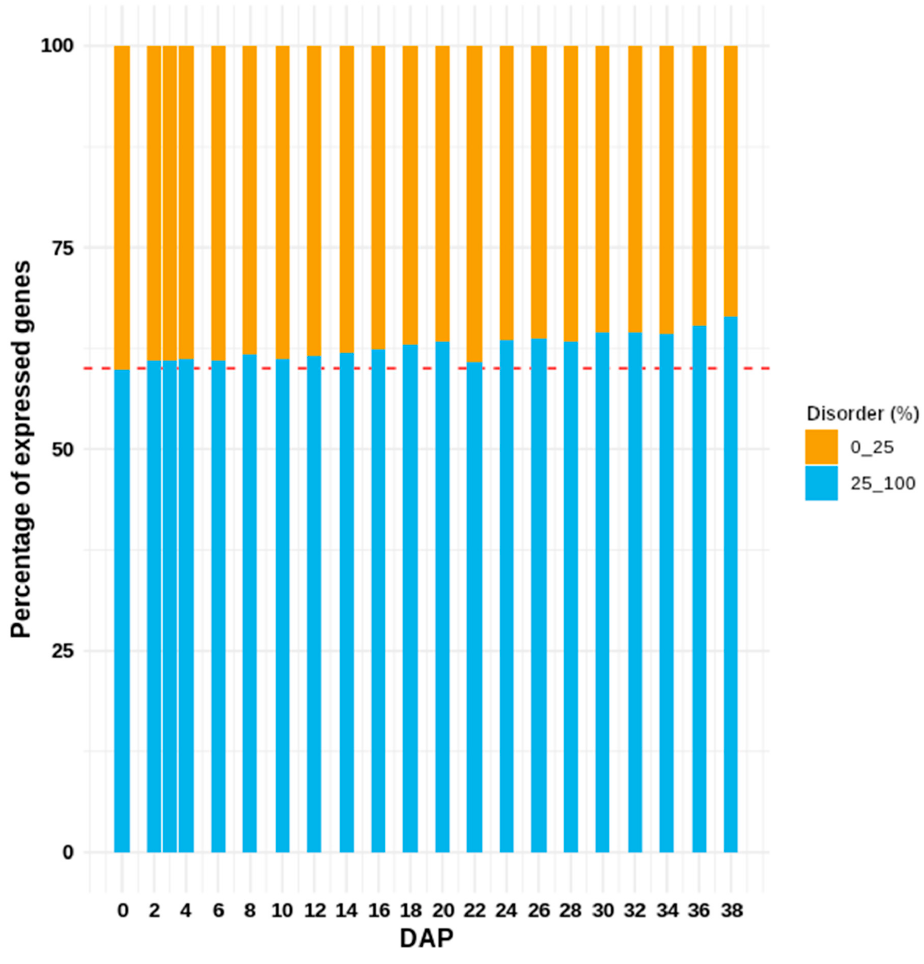
Figure 5. Dynamics in the relative composition of transcripts expressed throughout seed development. It is a clear reduction in the relative composition of structured proteins. The atypical data observed in the 22 DAP coincides with the peak of seed filling.